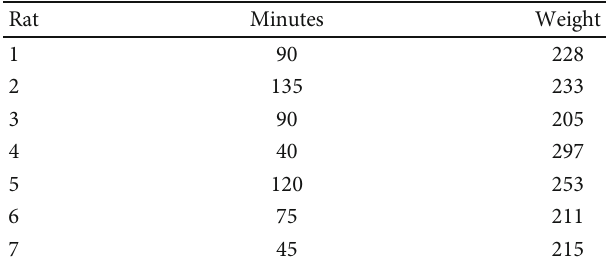
Table 1: Latency to status epilepticus (SE) in minutes and weight of rats. Rats were injected with pilocarpine (2.4mg/2 μ l, i.c.v.) until SE was